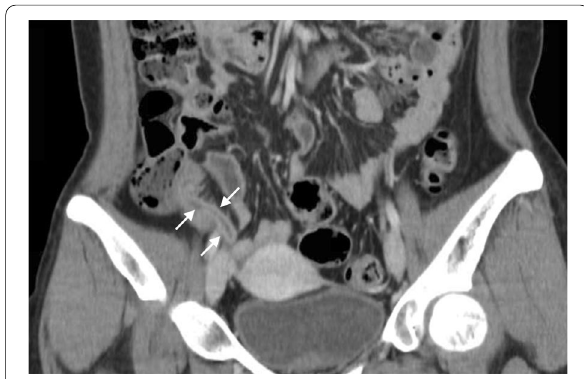
Fig. 2 Uncomplicated appendicitis. A coronal-reformatted CT image of a 35-year-old woman presenting with a 7-h onset of right lower quadrant pain, elevated white blood cell counts (11,590 cells/ mm 3 ) and neutrophilia (80.3% neutrophils) reveals a dilated